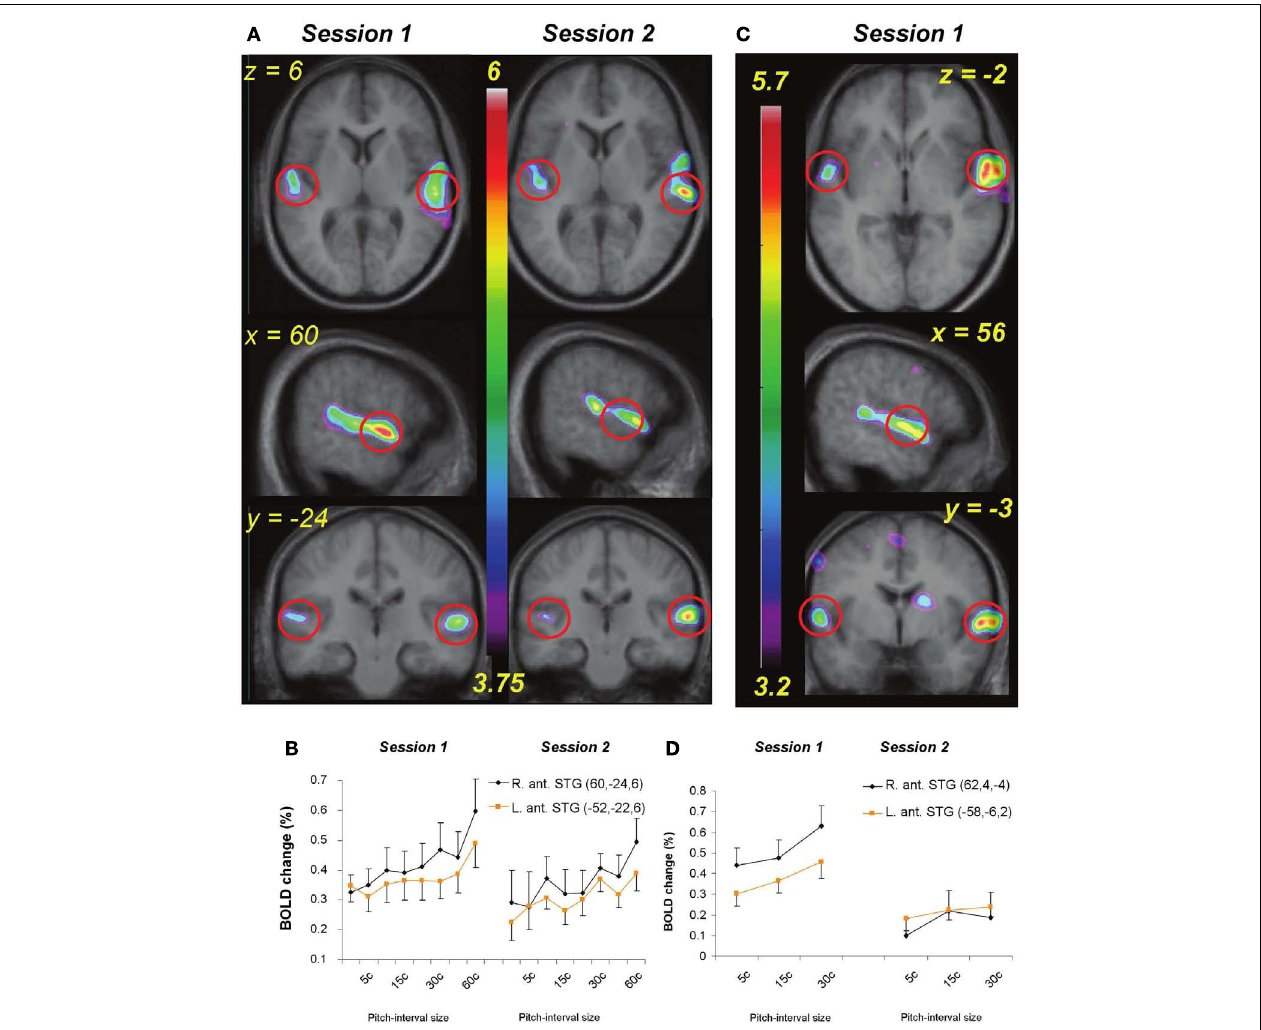
FIGURE 5 | (A) functional MRI data for the passive listening task before and after training (Session 1 and 2) shown in horizontal, sagittal, and coronal slices (top to bottom). Statistical parametric maps (color scale refers to t -values) indicate strength of the covariation between BOLD signal change and increasing pitch interval size of micromelodies; changes were confined to the superior temporal gyrus (STG). (B) Extracted BOLD values for two regions located in right and left anterior STG (indicated approximately by red circles in